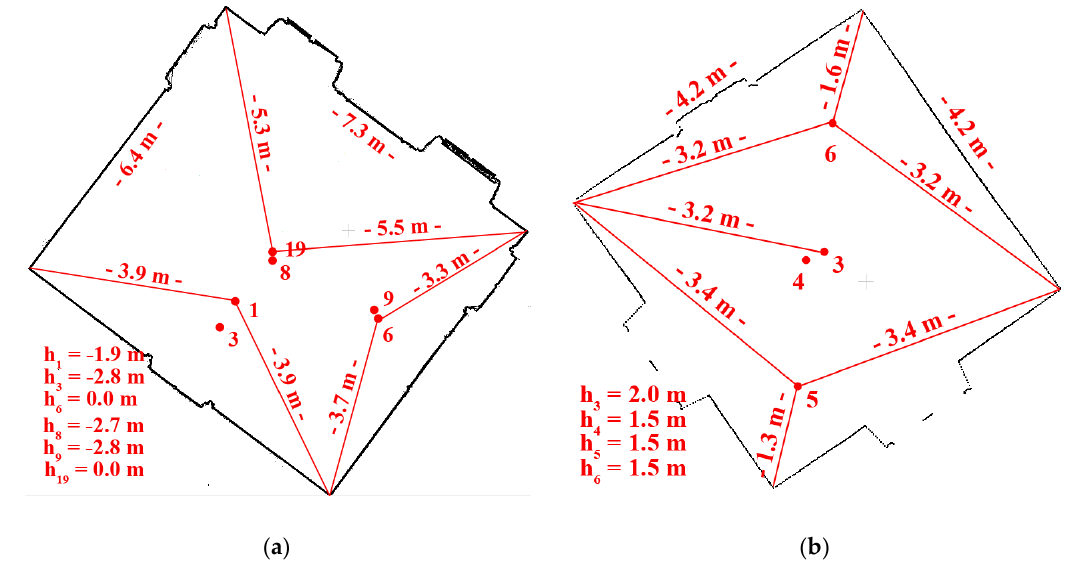
Figure 5. The floodplain with marked TLS scanner position with distances to the nearest walls for: ( a ) test site I: “The Queen’s Bedroom” and ( b ) site II: “The Chamber with a Parrot”. In the figures, the high of of each TLS station, related to the reference scan was presented. The h values are related to the high of the reference scan.